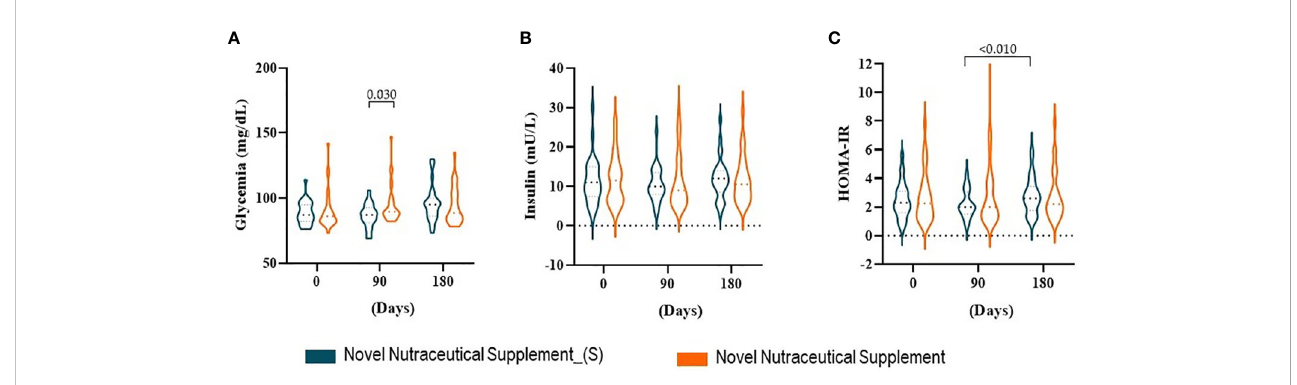
FIGURE 4 Carbohydrate pro fi le at baseline time (Day 0) and 90 and 180 days post-supplementation. (A) Glycemia. (B) Insulin. (C) HOMA-IR. Novel Nutraceutical Supplement_(S) (n = 30) and Novel Nutraceutical Supplement (n = 29). Values are expressed as mean ± SEM or median (min to max, box plot) by plot violin graphic. HOMA-IR, Homeostatic Model Assessment of Insulin Resistance.